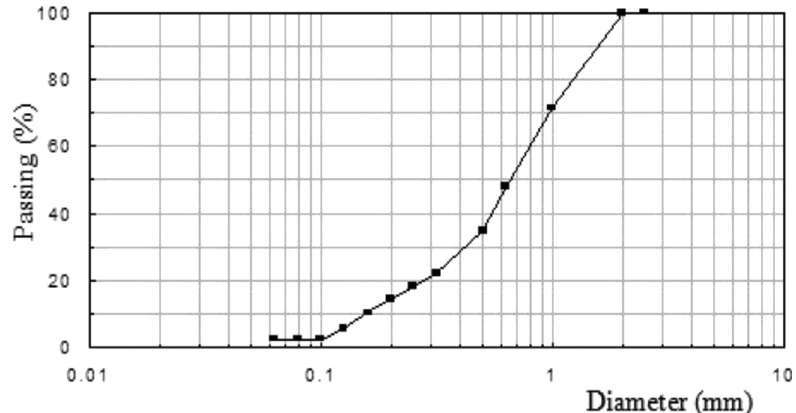
Figure 2: Size distribution of the aggregates used.